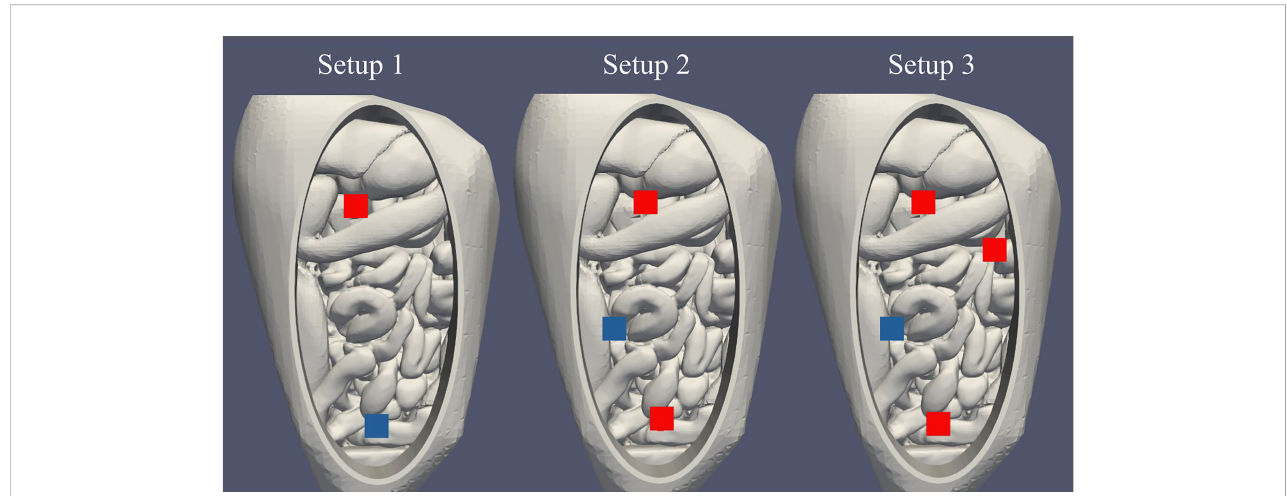
FIGURE 2 Visualization of the catheter setups used in this study. From left to right we show the positions for the 1 in fl ow/1 out fl ow, 2 in fl ow/1 out fl ow and 3 in fl ow/1 out fl ow cases, respectively. In fl ows are visualized in red, the out fl ow in blue. For setup 1, the in fl ow was positioned near the liver and the out fl ow was positioned near the rectum. For setup 2, in fl ows were positioned near the liver and rectum and the out fl ow was positioned slightly right to the patient ’ s center to allow the catheter tips to be at a depth of 3 cm. For setup 3, in fl ows were positioned near the liver, descending colon and rectum and the out fl ow was positioned slightly right to the patient ’ s